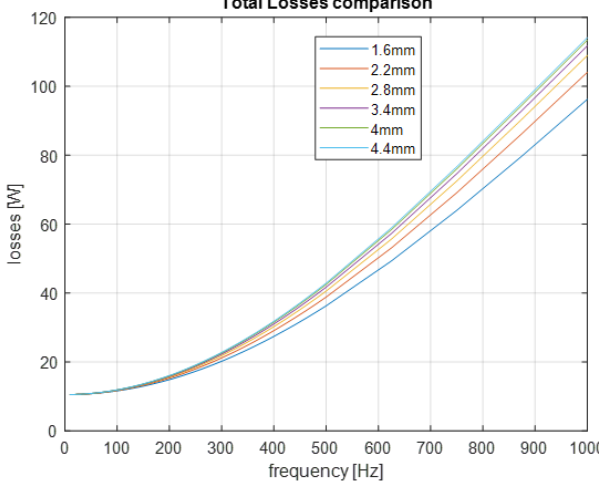
Figure 12. Trapezoidal slot—total losses